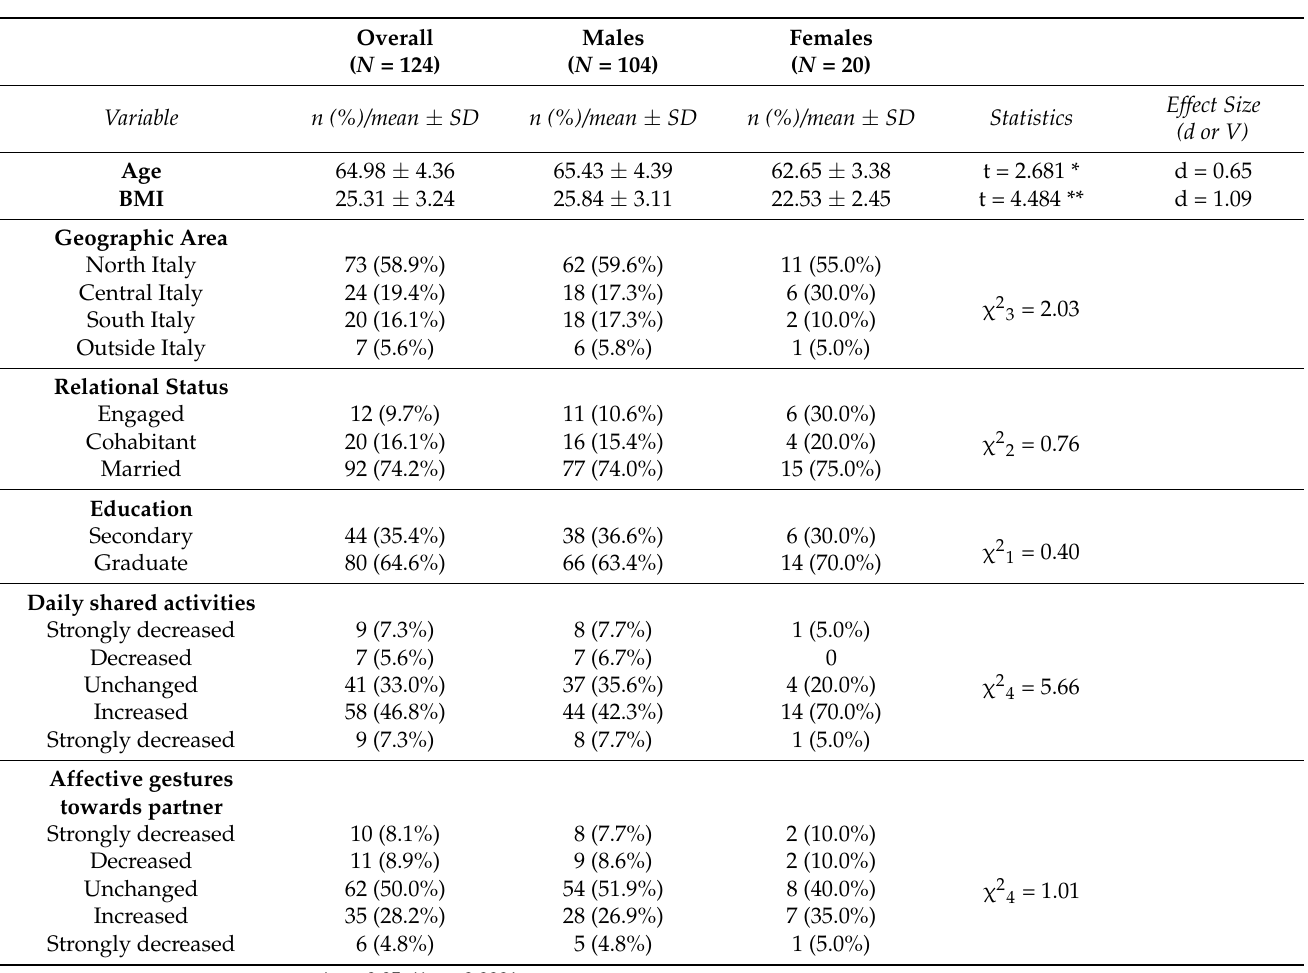
Table 1. Sample characteristics and univariate comparisons between the male and female subjects of the study